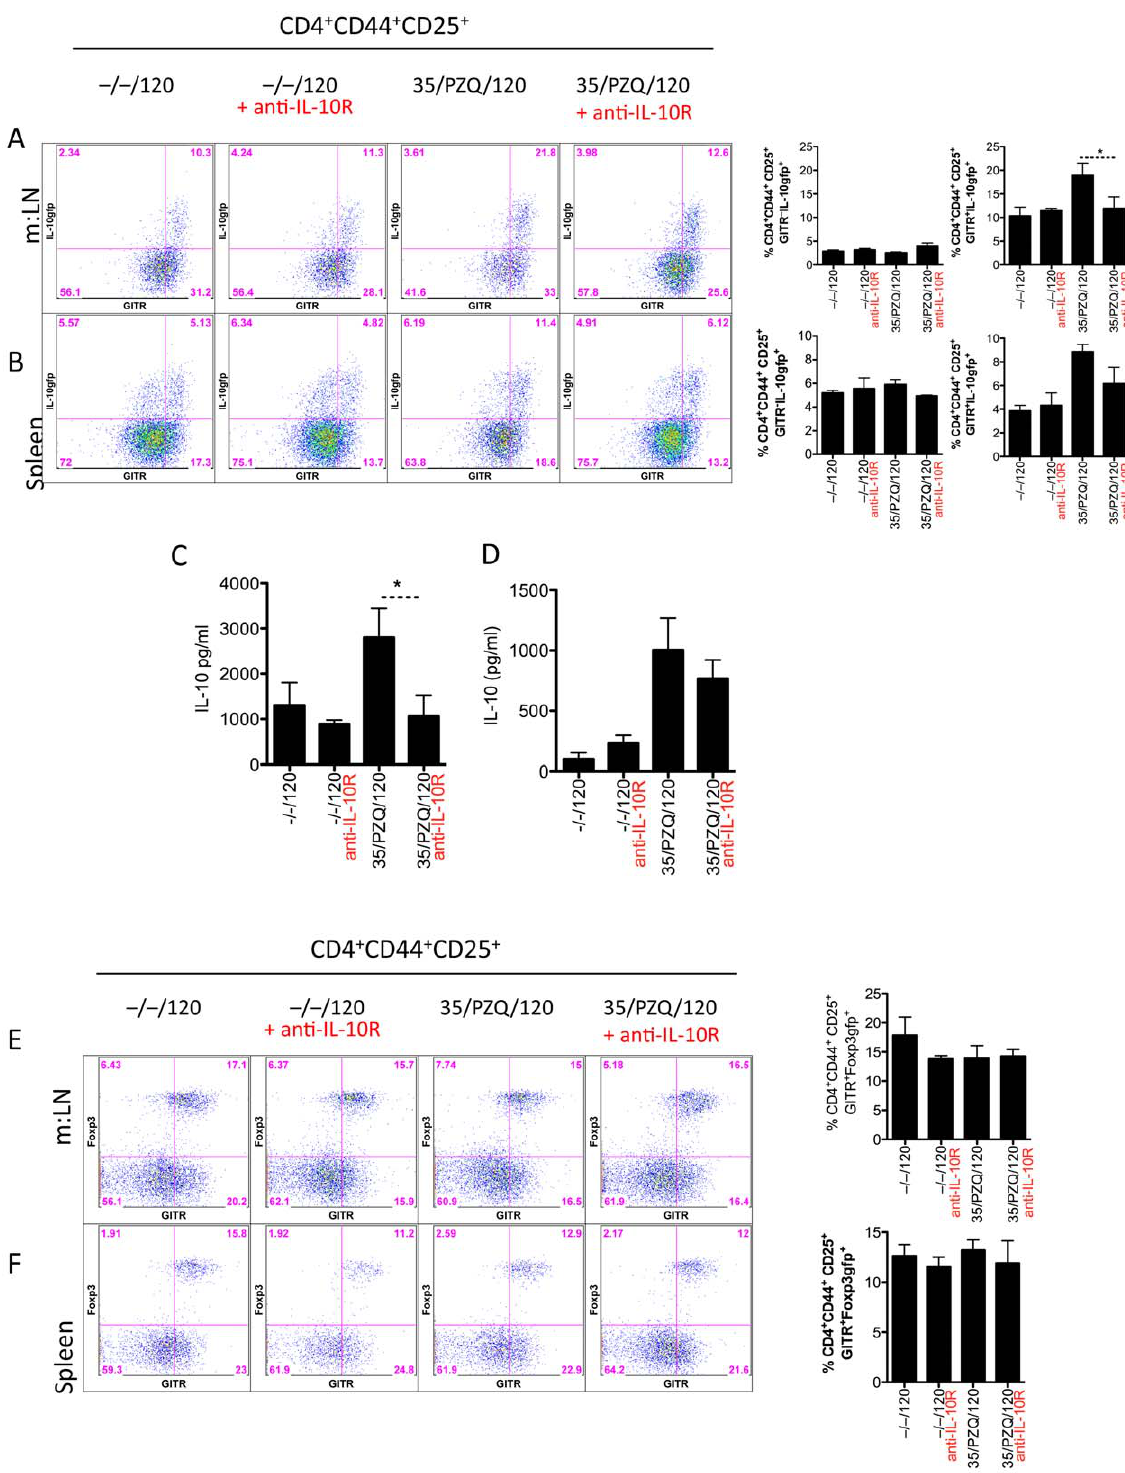
Figure 6. IL-10 blockade, reduces IL-10 producing cells, IL-10 secretion from spleen and mesenteric lymph nodes, with unchanged Foxp3 + cells. C57BL/6 or Foxp3 gfp -reporter mice were infected and treated, as in Figure 5, with cells recovered at necropsy. Data shown are mean 6 SEM from one of 2 experiments, with 5 mice per group. (A) GITR + IL-10gfp + mesenteric lymph nodes cells within the CD4 + CD44 + CD25 + population. (B) GITR + IL-10gfp + splenocytes within the CD4 + CD44 + CD25 + population. (C) IL-10 secretions, measured by ELISA, from adult worm antigen re-stimulated. mesenteric lymph node cells. (D) IL-10 secretions, measured by ELISA, from adult worm antigen re-stimulated splenocytes. (E) GITR + Foxp3 + mesenteric lymph nodes cells within the CD4 + CD44 + CD25 + population, using Foxp3 gfp reporter mice. (F) GITR + Foxp3 + splenocytes within the CD4 + CD44 + CD25 + population, using Foxp3 gfp reporter mice.